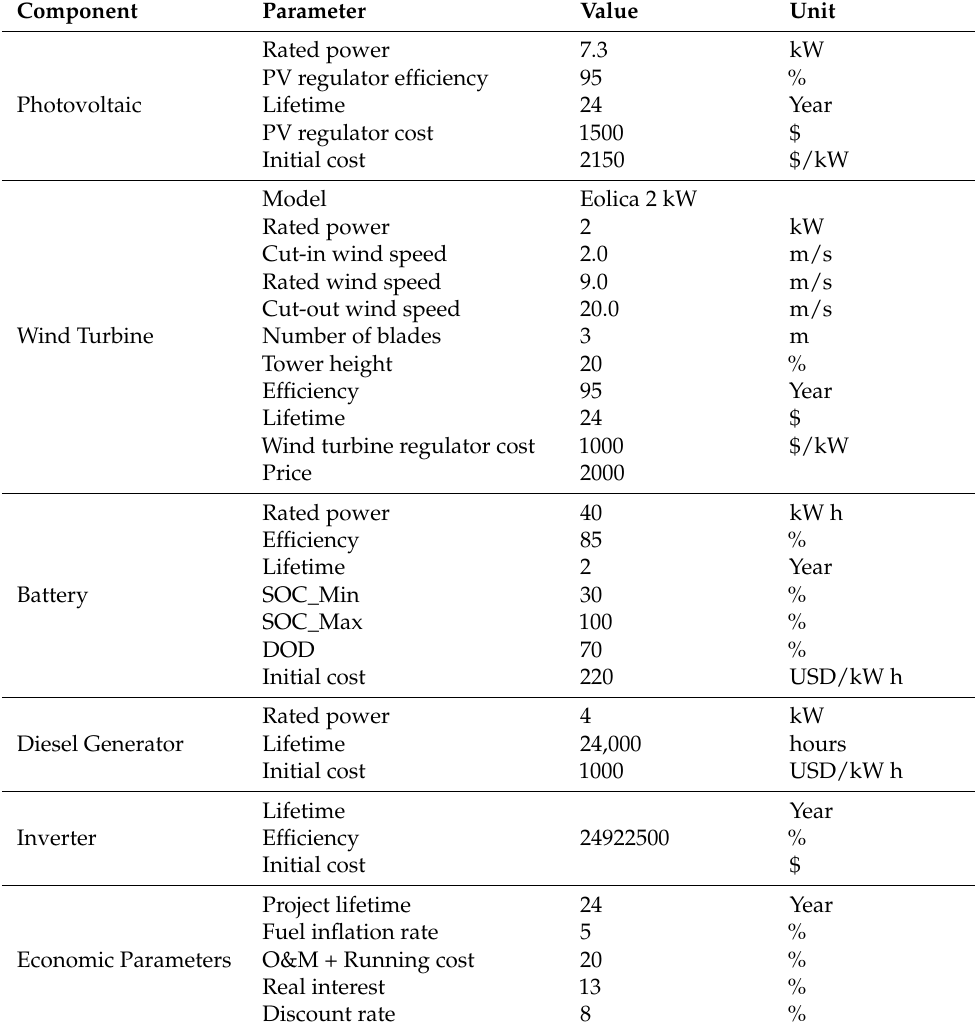
Table 4. Technical and economic specifications of the HMGS components [6,32,36].